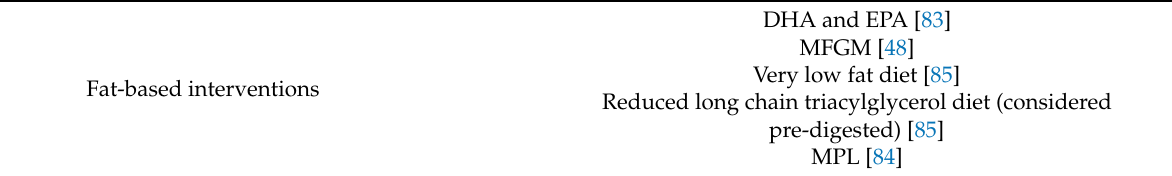
Table 3. Enteral feeding interventions reducing clinical disease score or signs and symptoms in experimental animal models of